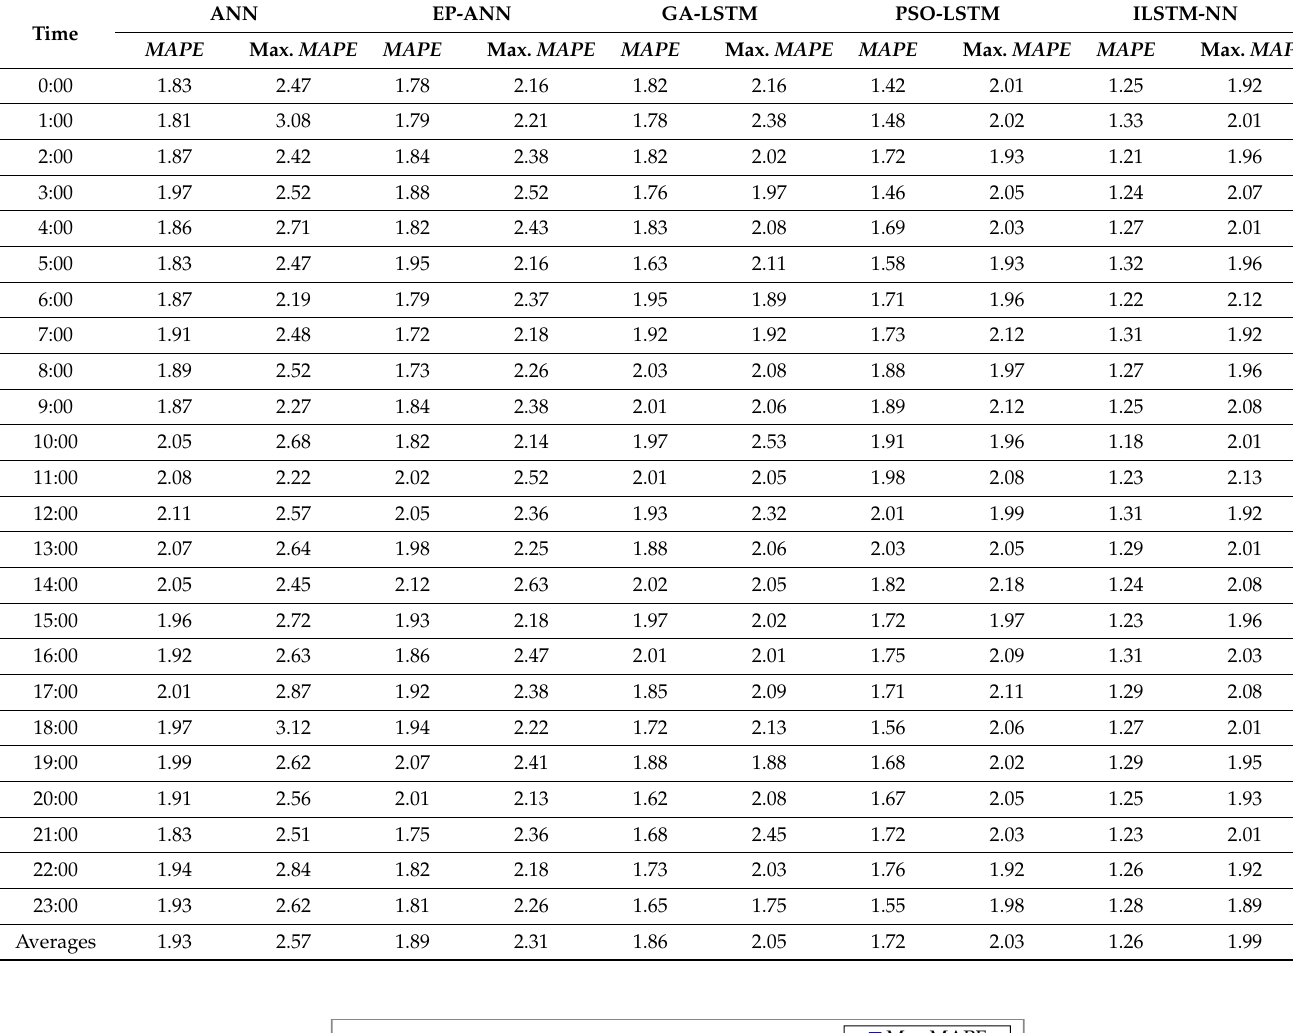
Table 3. Different methods used to measure the difference between MAPE Max and . MAPE . Mean- while, the hours are measured at different time points within 24 h of the “working day” (Thursday 15